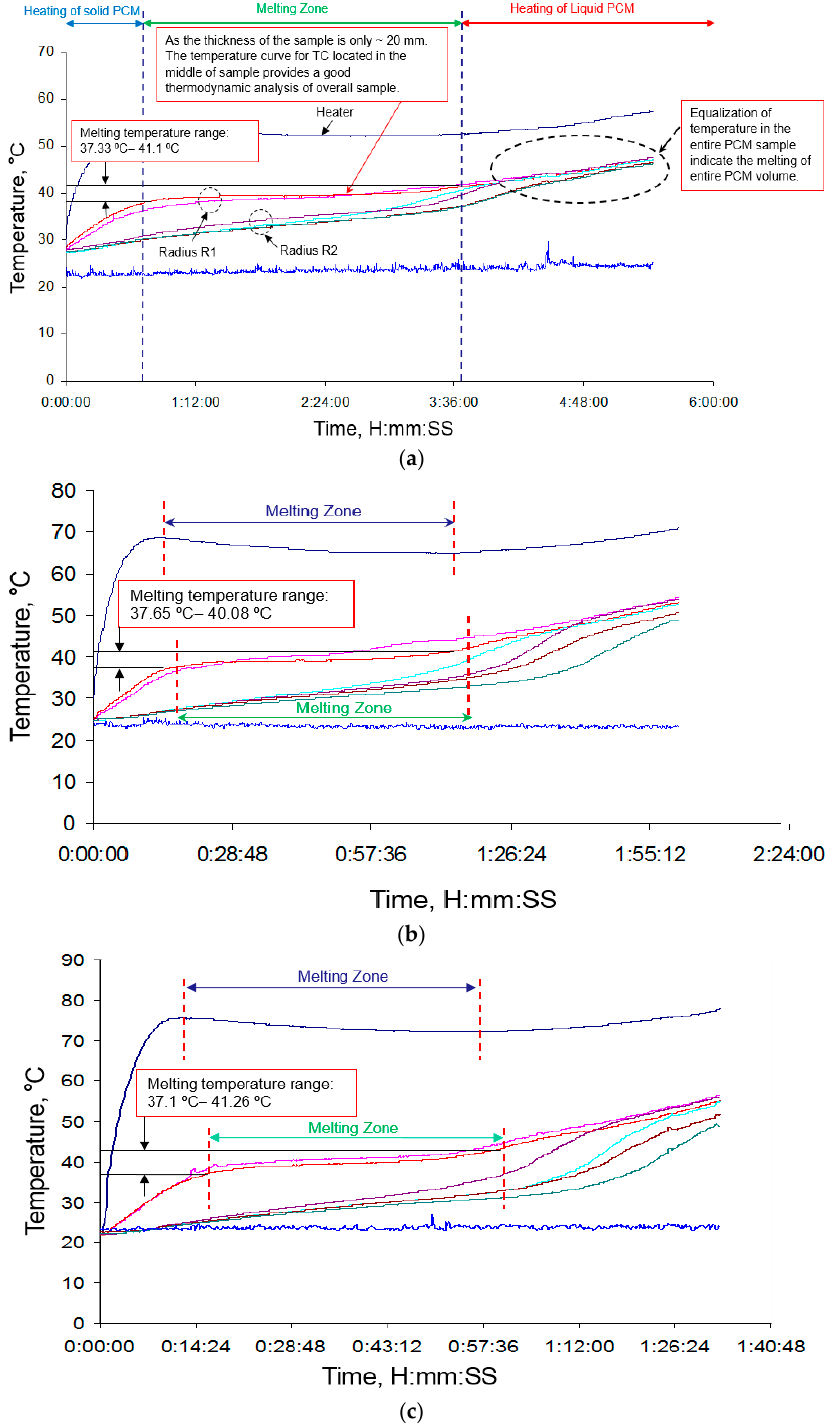
Figure 9. ( a ) Heat exchange process inside the PCM test sample under 1.04 W input power analyzed by cylindrical configuration method. ( b ) Heat exchange process inside the PCM test sample under 2.34 W input power analyzed by cylindrical configuration method. ( c ) Heat exchange process inside the PCM test sample under 3.15 W input power analyzed by cylindrical configuration